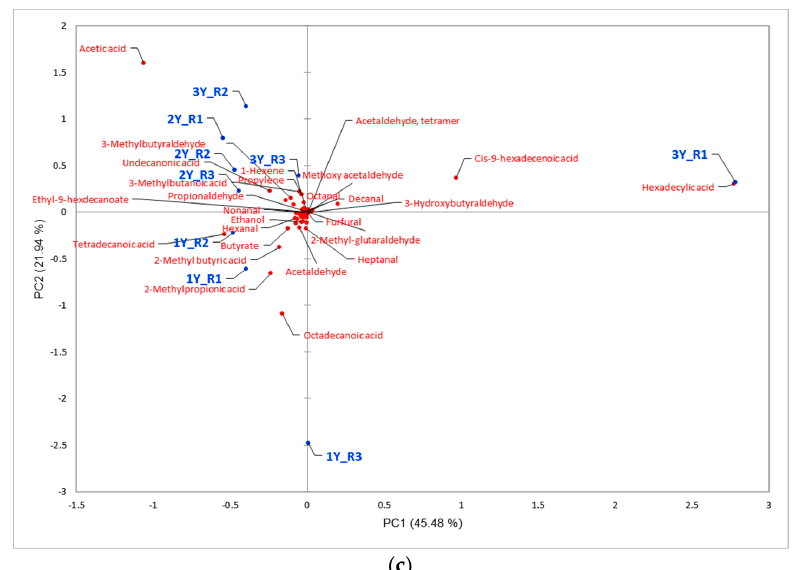
Figure 3. Principal component analysis of volatile components of Jinhua hams at different points in the aging process (1Y, 2Y, and 3Y) using SAFE ( a ), SPME ( b ), and NT ( c ); R1, R2, R3 represent three replications of each aged ham.